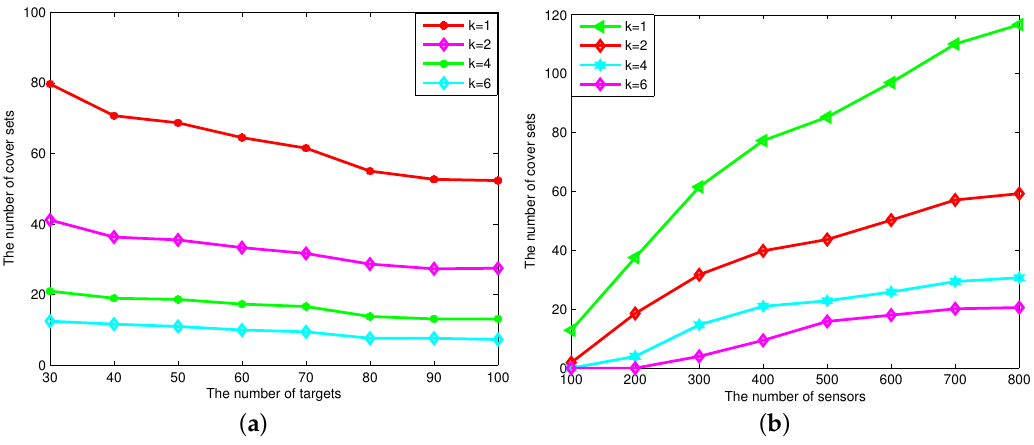
Figure 9. The number of connected cover sets generated vs. the number of targets and the number of sensor nodes. ( a ) The number of cover sets changes when the number of targets changes; ( b ) the number of cover sets changes when the number of sensors